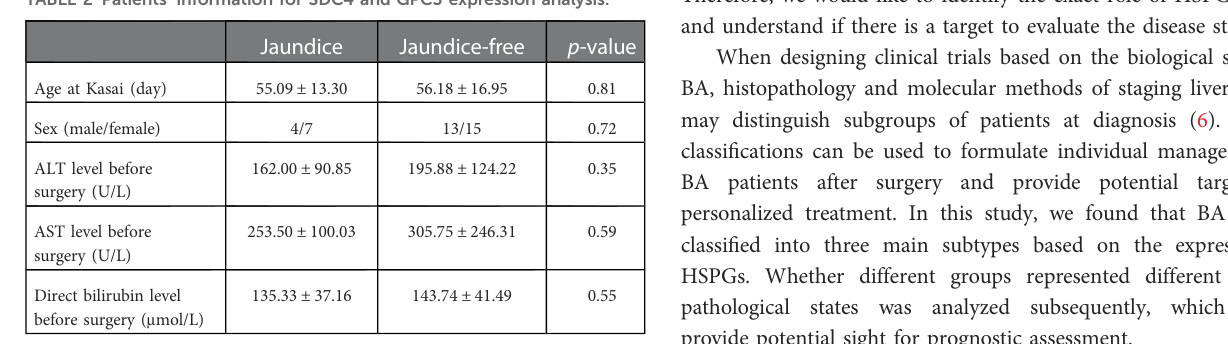
TABLE 2 Patients ’ information for SDC4 and GPC3 expression